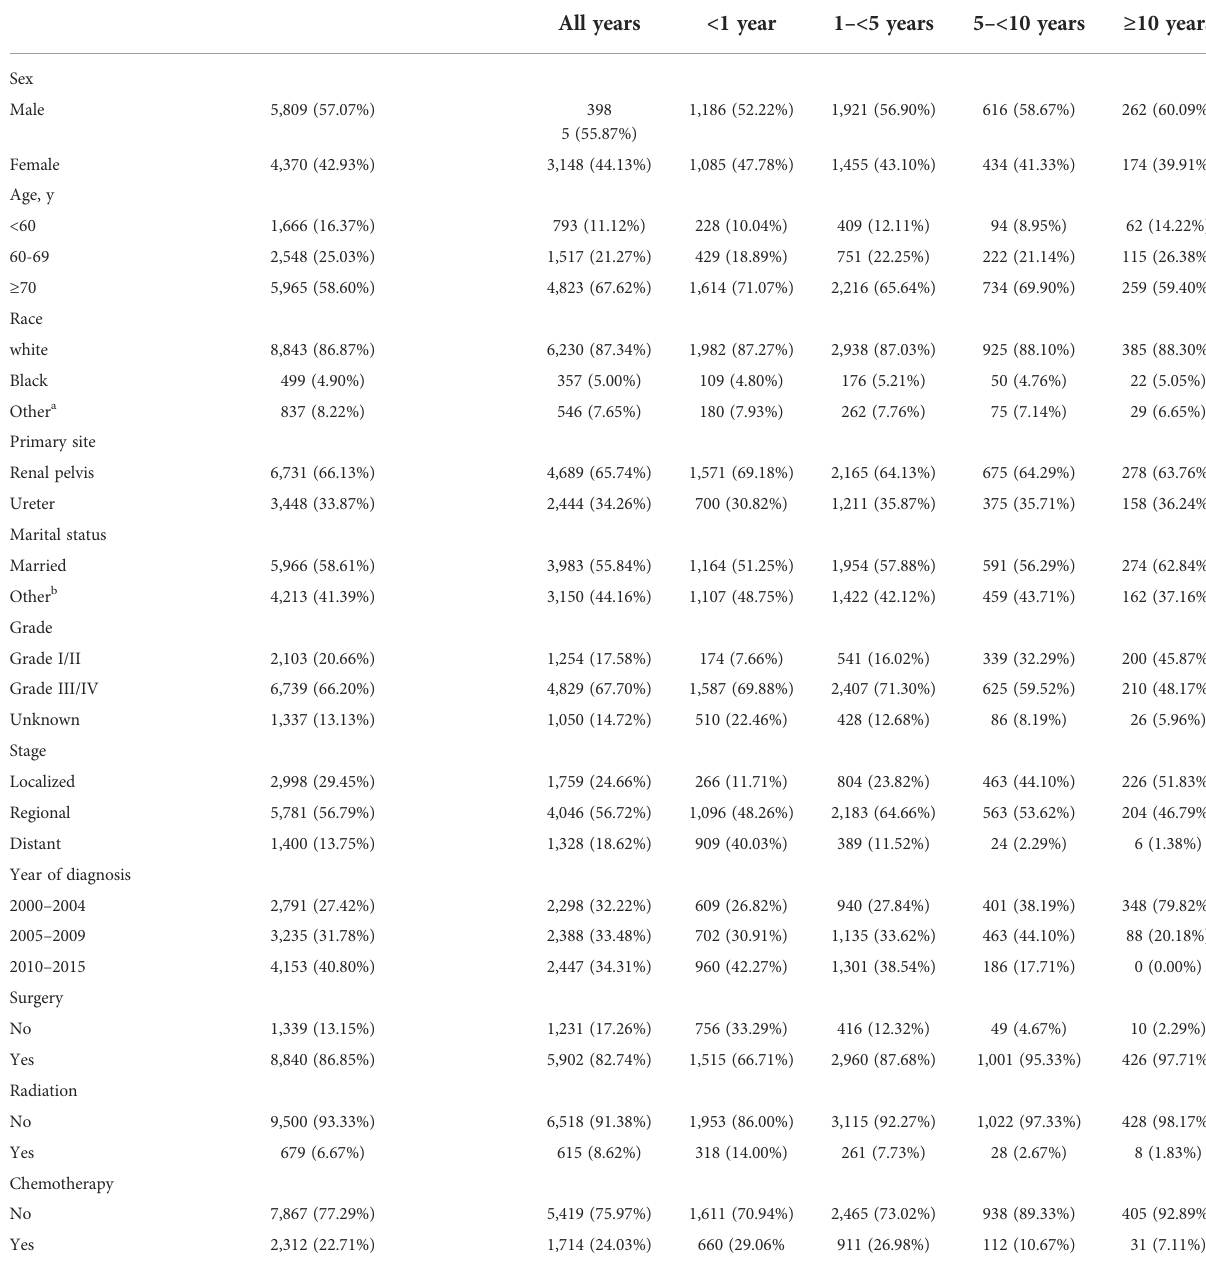
TABLE 1 Patient characteristics and death by time after diagnosis. Group All patients diagnosed with UTUC,